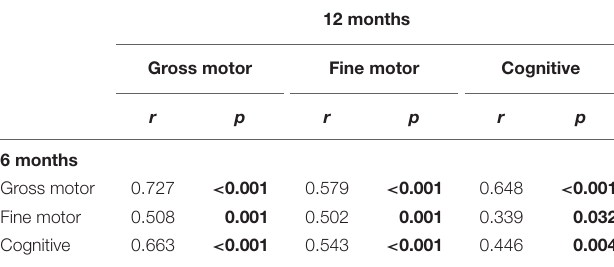
TABLE 3 | Pearson’s correlations among gross motor, fine motor and cognitive scores at 6 and 12 months.